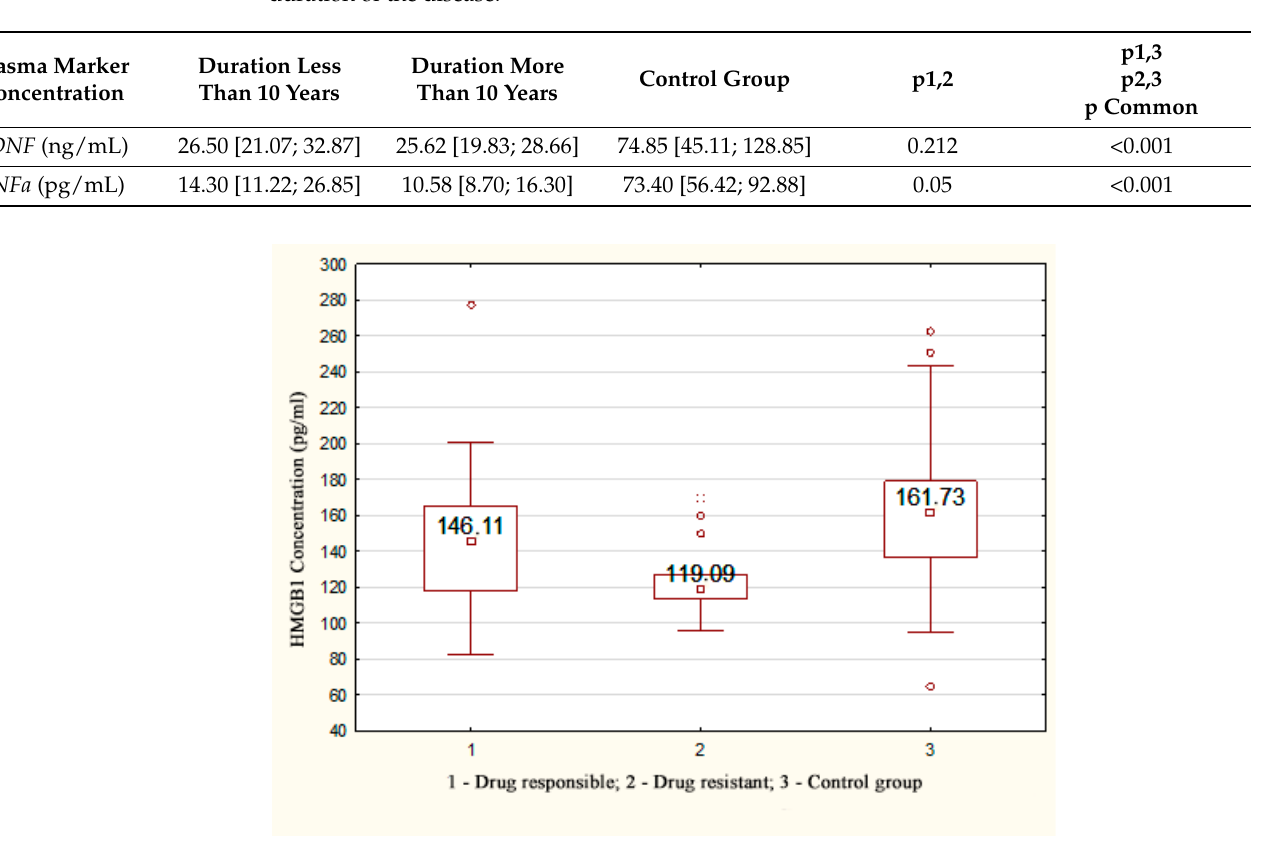
Table 3. The significant alteration in the concentration of the markers of neuroinflammation and neurodegeneration in the blood plasma of patients in the TLE and control groups, depending on the duration of the disease.